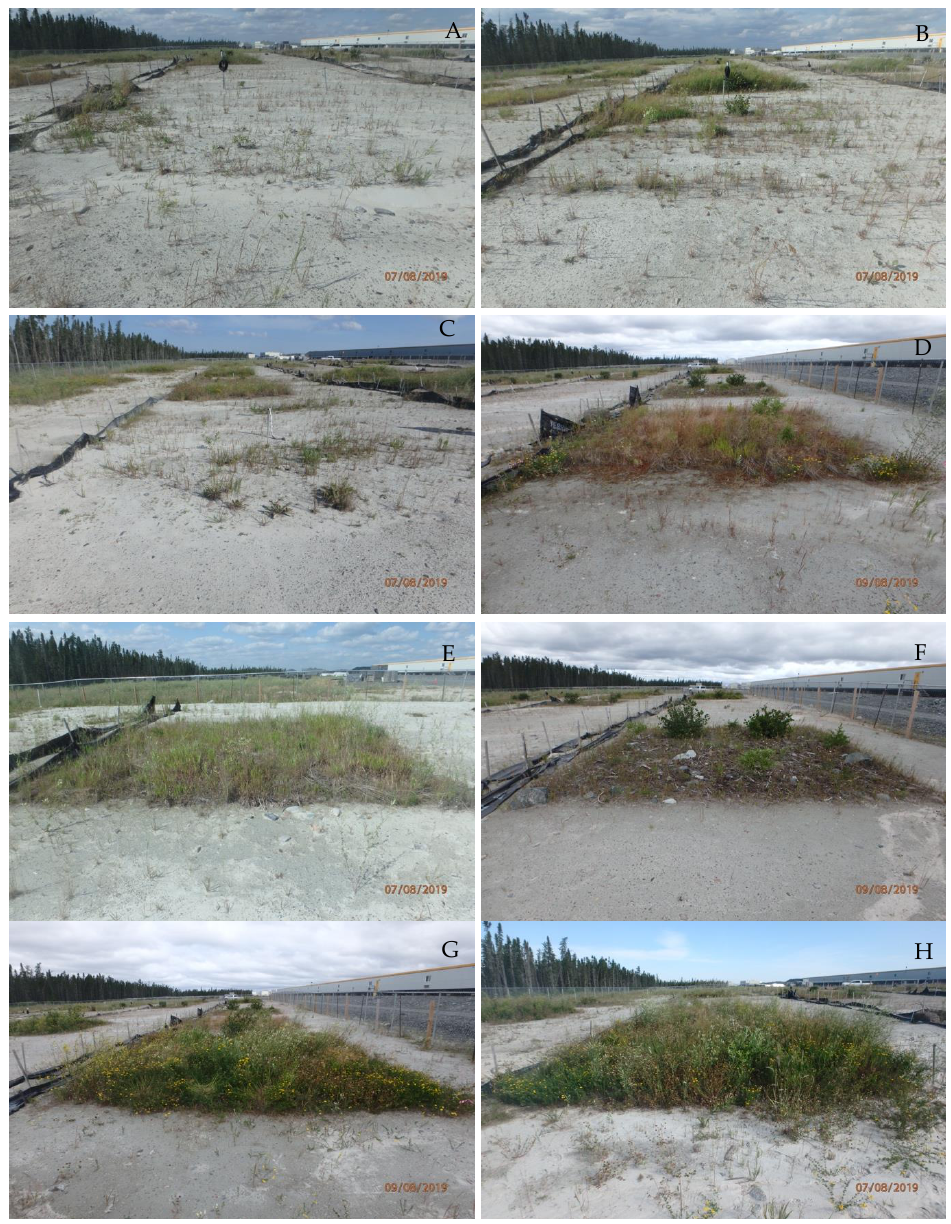
Figure 2. Photograph of each treatment type from August 2019. Subfigure indicates treatment ( A ) Control, ( B ) Control + Biosolids, ( C ) Control + Oats, ( D ) Control+ Fertilizer, ( E ) Control+ Oats + Fertilizer, ( F ) Control + Peat, ( G ) Control + Peat + Biosolids, ( H ) Control + Peat + Fertilizer.